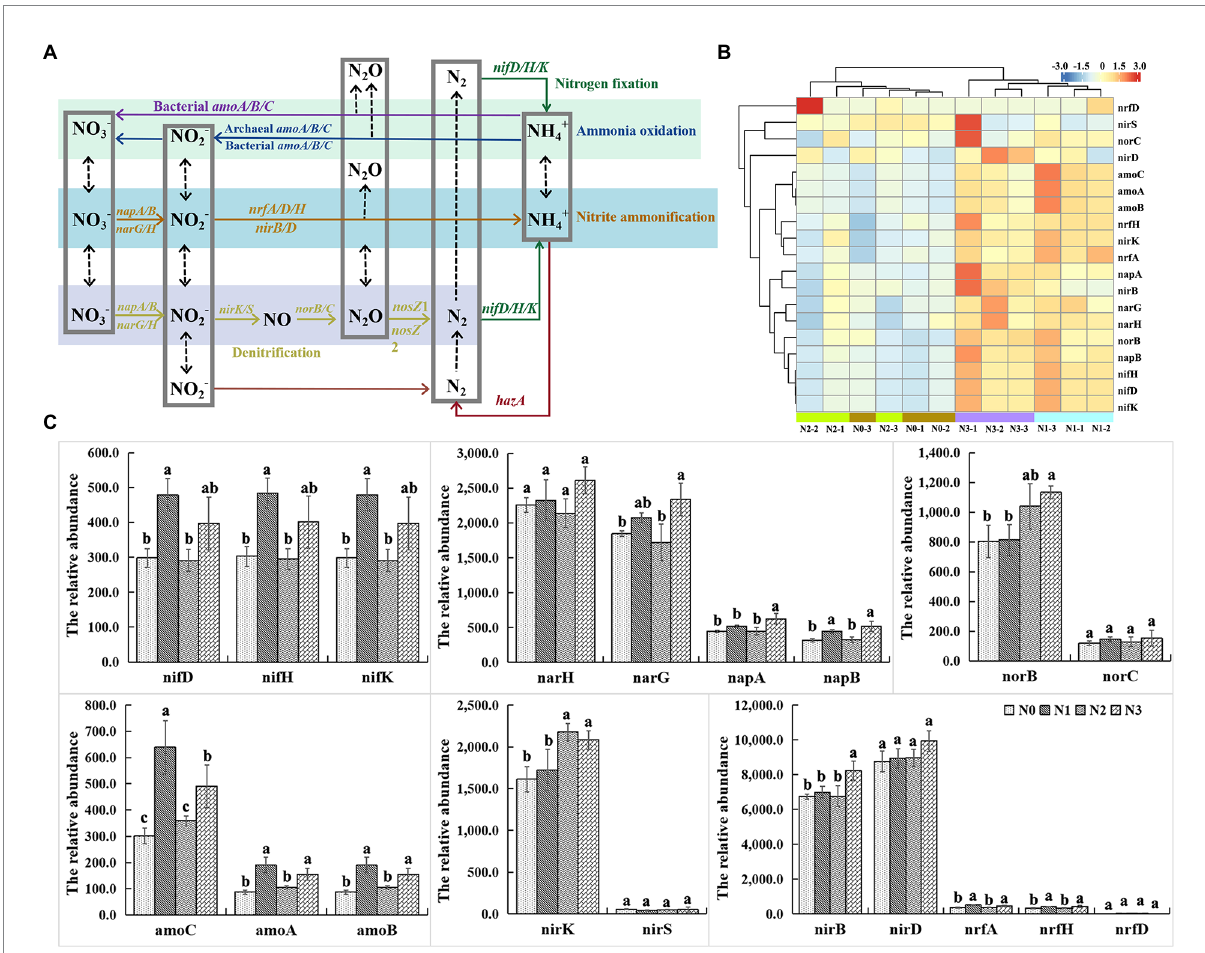
FIGURE 5 Influences of experimental N addition on nitrogen metabolism related